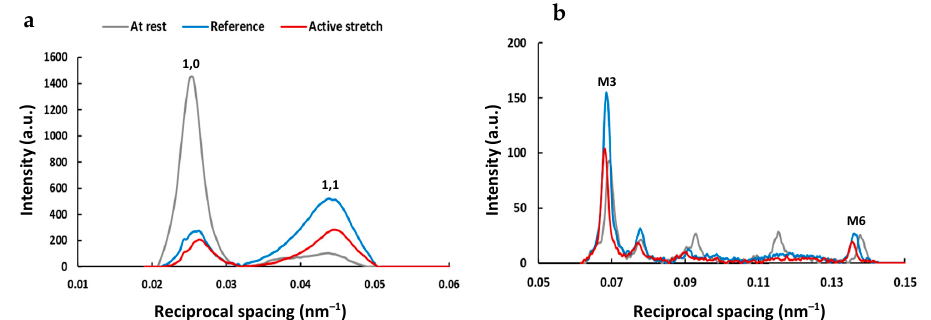
Figure 1. Typical 2D X-ray intensity peak profiles of the equatorial 1,0 and 1,1 and the meridional M3 and M6 reflections recorded at an average SL of 3.0 µm, at rest (gray) and at steady-state isometric contraction following a purely isometric reference contraction (blue) and an active lengthening contraction (red). ( a ) X-ray intensity peak profiles of the equatorial 1,0 and 1,1 reflections; ( b ) X- ray intensity peak profiles of the meridional M3 and M6 reflections. Intensity peak profiles were determined in 11 bundles for three conditions (rest, reference, and active stretch). Bundles underwent individual X-ray exposures of 0.5 s in total, and the X-ray patterns were collected as a continuous series of 18 ms frames separated by 2 ms in order to minimize radiation damage.